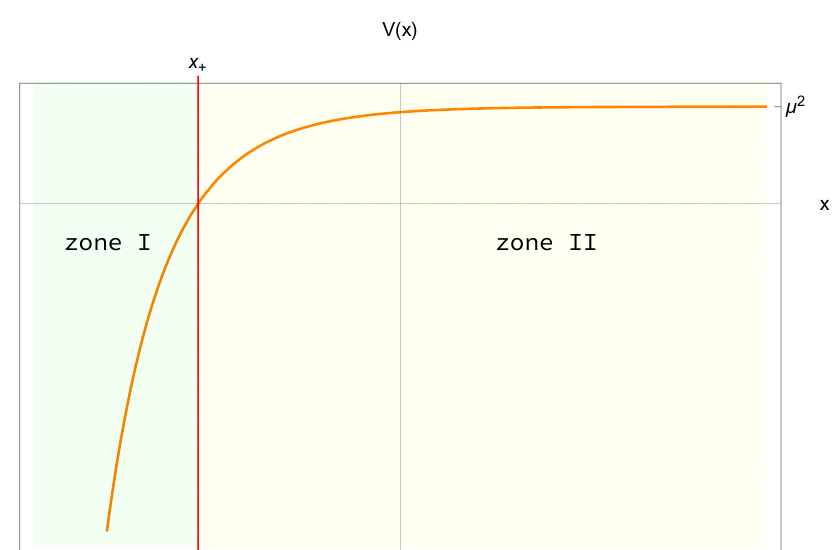
Figure 3: Schematic description of a potential V ( x ) with one turning point, x + and the two zones depending on the sign of V ( x ) . For the illustration, we have considered that V ( x ) tends to −∞ at −∞ but it is not necessary for the discussion. Any kind of behavior is possible as long as V ( −∞ ) <